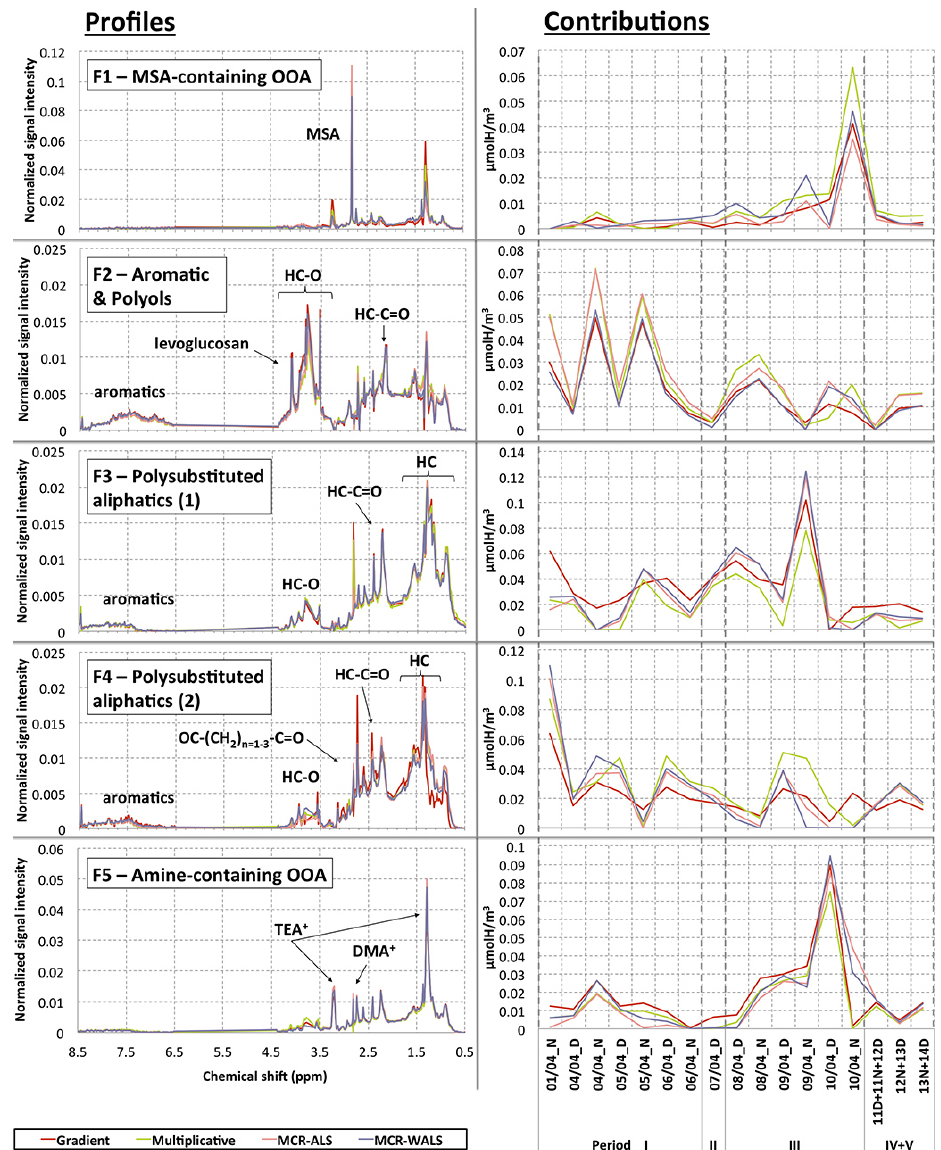
Figure 5. Profiles and contributions of five-factor solutions from 1 H-NMR spectra factor analysis. Results from all four different algorithms were reported: the projected gradient (red line), Multiplicative (green line), MCR-ALS (orange line) and MCR-WALS (violet line). The signal intensity of the spectral profiles was normalized (integral=1). The samples suffixes indicate day-time (_D) and night-time (_N) sampled filters. For more details refer to the text. Table 4. Pearson correlation coefficients ( R ) between NMR WSOC factors and simple chemical tracers. Only R values > 0.3 are